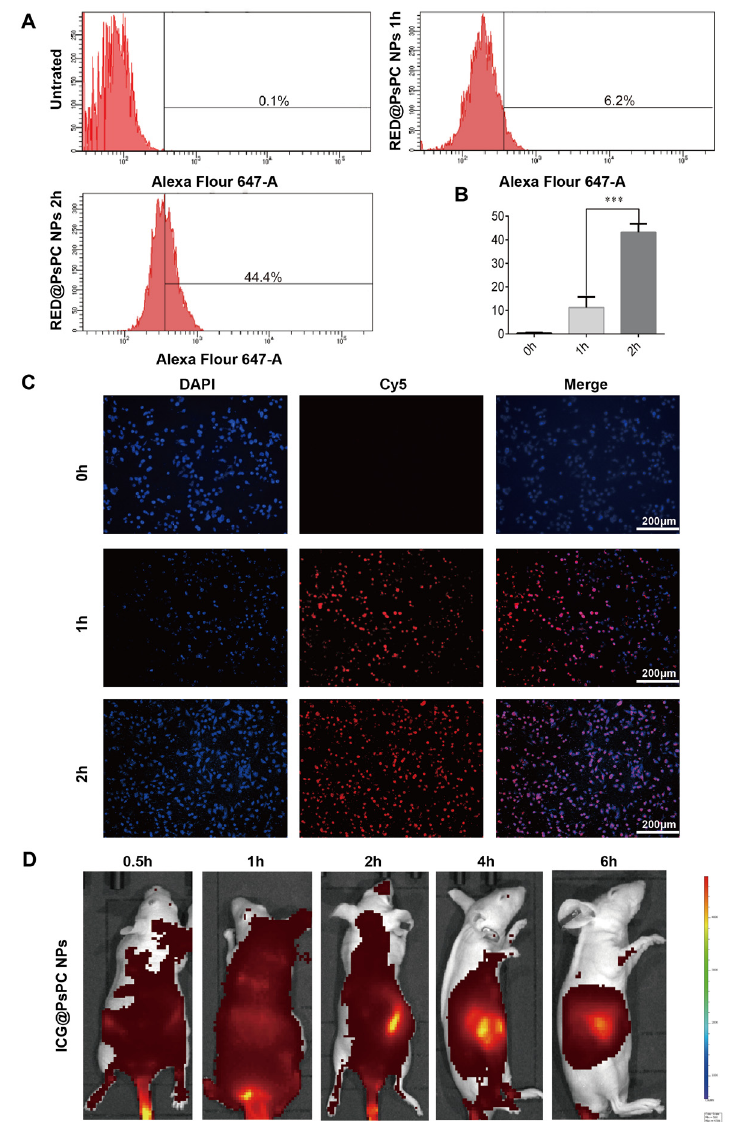
Figure 4. The cellular uptake of nanoparticles in vitro and its tumor-target ability in vivo. Huh7.5-luc cells were incubated with RED@PsPC NPs containing Cy5 for various time points, as indicated. Cells were washed by PBS and red stained cells were measured by flow cytometry ( A ), with data being quantified in ( B ), *** p < 0.001, n = 3. ( C ) Cells in A were evaluated by microscopy. Scale bar indicates 200 µm. ( D ) Tumor bearing mice were received tail vein injection of ICD@PsPC NPs containing indocyanine green (ICG). The fluorescence intensities were photographically recorded by IVIS Lumina LT at various time points, as indicated.